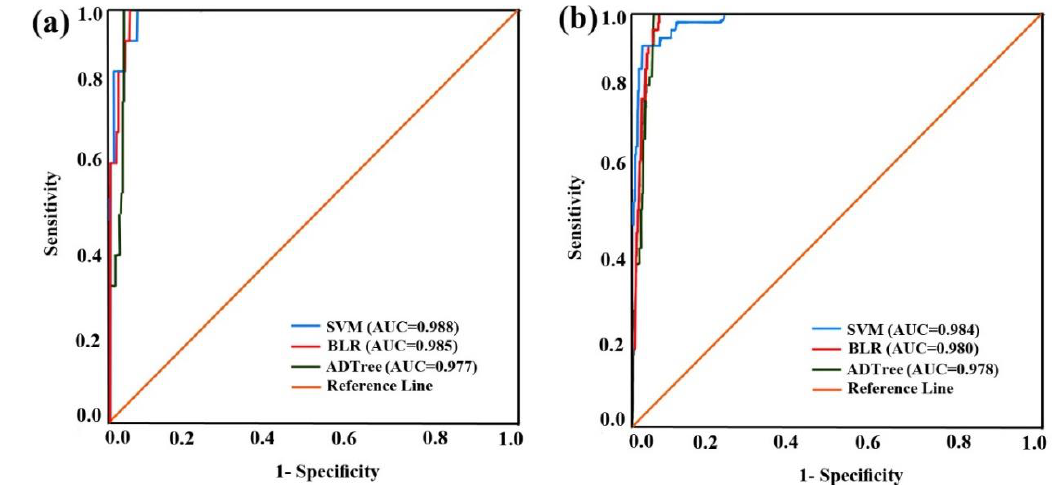
Figure 7. ROC curve and AUC for the SVM, BLR, and ADTree models: ( a ) training and ( b ) validation datasets.